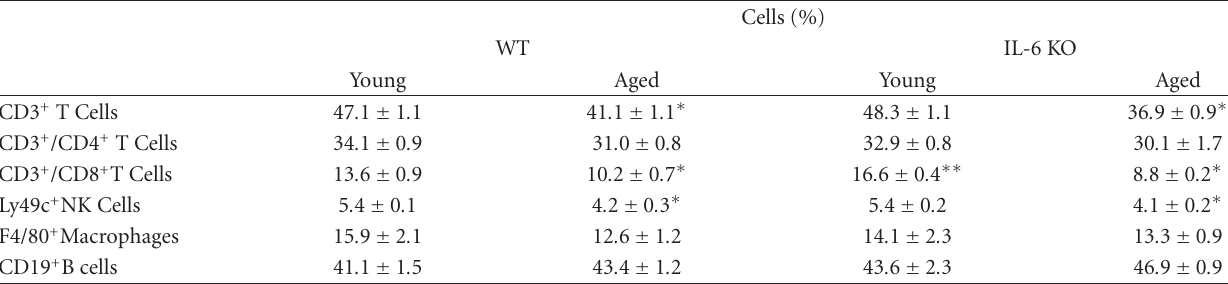
Figure 1: Splenic macrophages obtained from young and aged WT and IL-6 KO mice were cultured for 18 hours with LPS (100ng/ml). Supernatants collected were assayed for TNF α (a), IL-1 β (b), IL-6 (c), and IL-12 (d), by ELISA. Data are shown as mean ± SEM of 4-5 mice per group. ∗ P < . 05 from young WT. # P < . 05 from young WT. † P < . 05 from young IL-6 KO. @ P < . 05 from aged WT. Table 1: E ff ects of age and IL-6 on splenocyte cell populations.